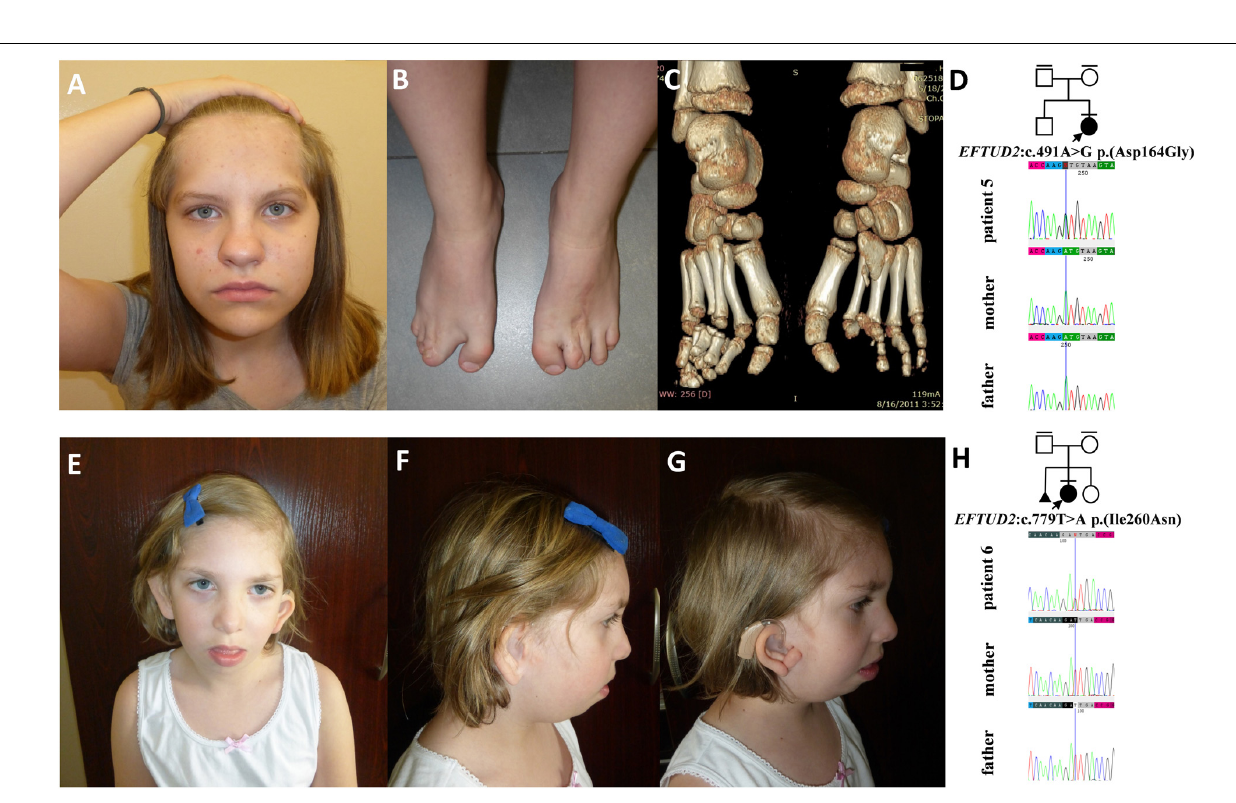
Frontiers in Genetics |